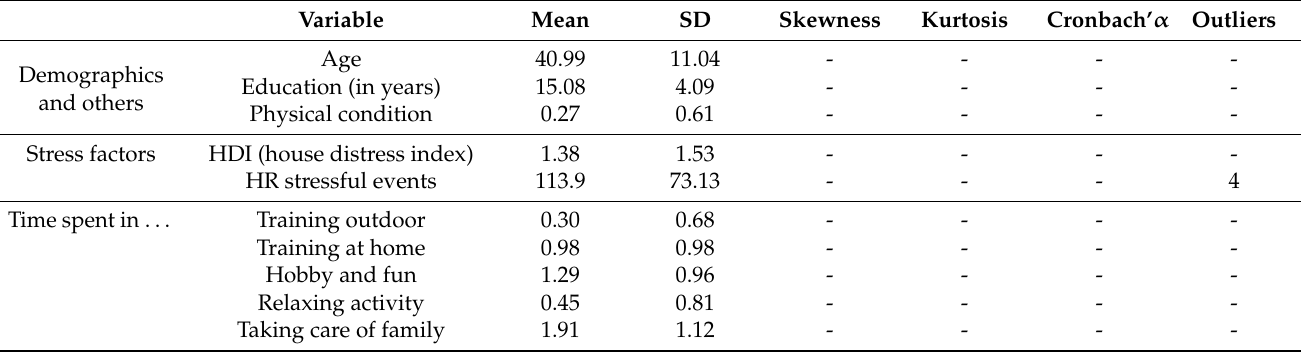
Table 1. Descriptive statistics for demographic, stress factors, lockdown activity, coping strategy, and psychological